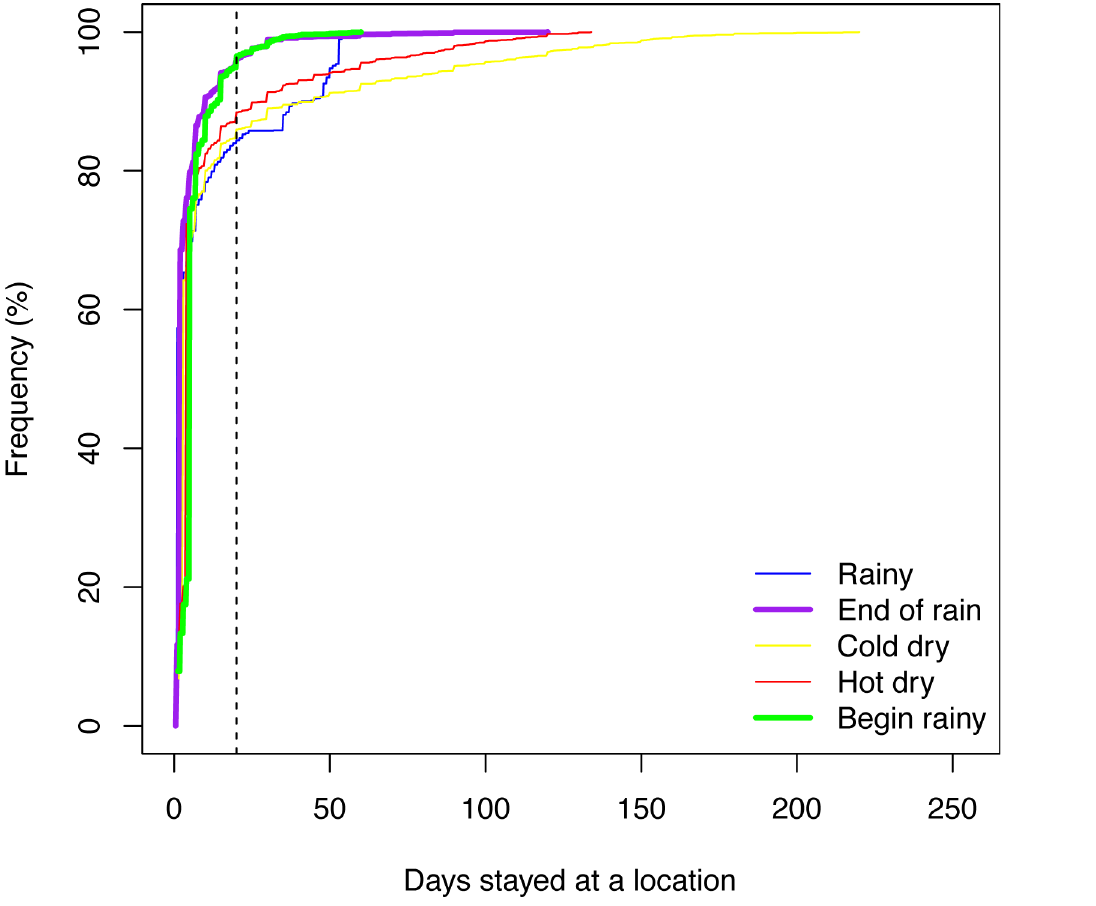
Fig 2. Cumulative distributions of the days of stay. The dashed vertical line indicates the stay of 20